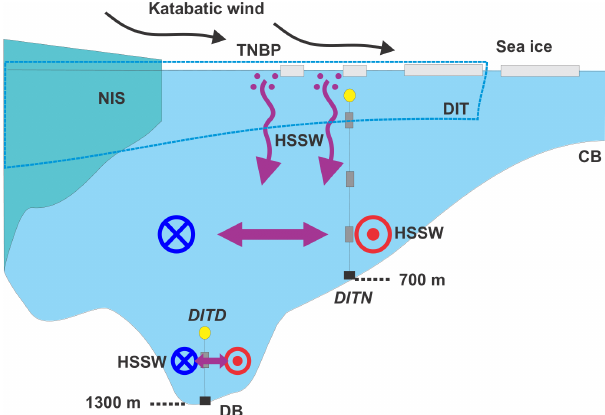
Figure 14. A schematic of the spatiotemporal variations in the pro- duction of HSSW in TNBP. The downward arrows show HSSW for- mation through convection from brine rejection (dots) during sea- ice formation at the surface in the polynya opened by off-shelf kata- batic winds. The horizontal bidirectional arrows indicate that the HSSW that formed near the Nansen Ice Shelf (NIS) advects at the deepest depths of both the eastern Terra Nova Bay (DITN) and Dry- galski Basin (DITD) via cyclonic pattern flows in TNBP. The blue and red circles represent flow into and out of the polynya. DB, CB, and DIT denote the Drygalski Basin, Crary Bank, and Drygalski Ice Tongue,